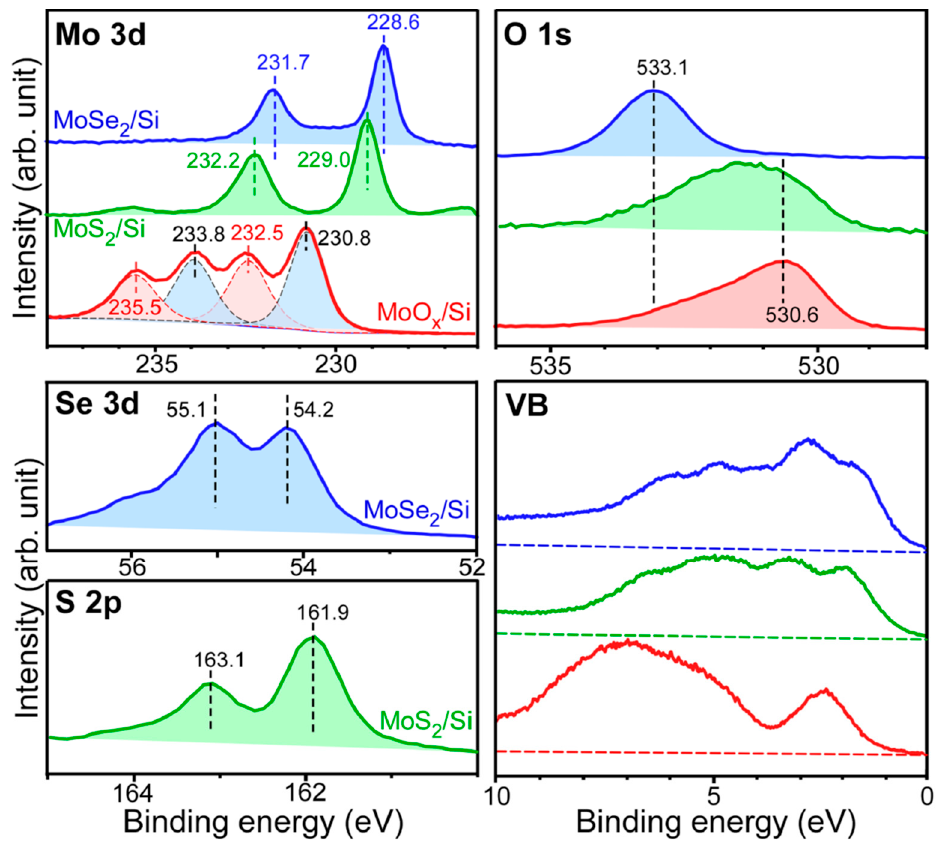
Figure 3. Mo 3d, O 1s, Se 3d, S 2p and valence band (VB) X-ray photoelectron spectra (XPS) for MoO x /Si, MoS 2 /Si and MoSe 2 /Si samples.